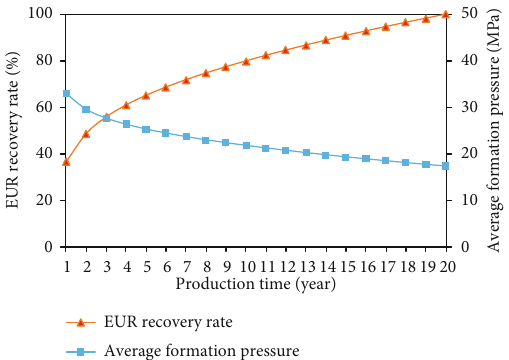
Figure 4: Shale gas EUR recovery rate and average formation pressure versus production time.